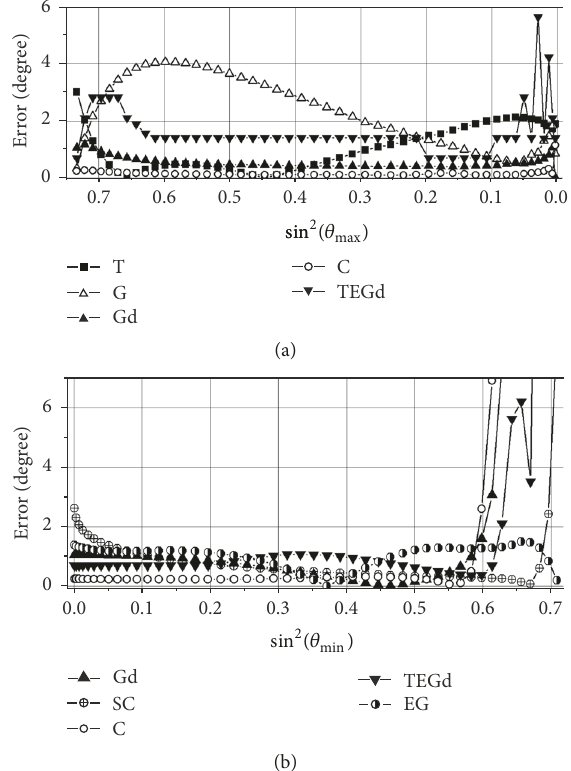
Figure 6: Techniques of higher quality, variant 𝑉 𝑃3 = 4800 : (a) the fixed minimum offset and (b) the fixed maximum